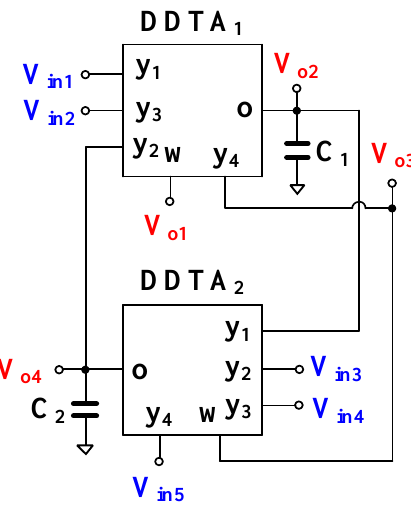
Figure 4. MIMO universal filter using DDTAs.